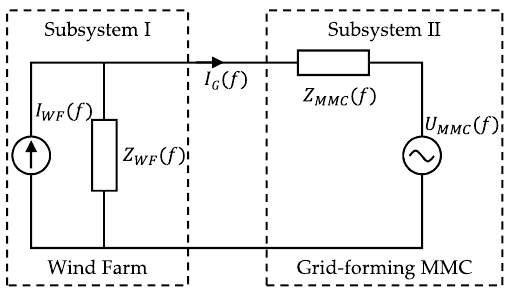
Figure 26. Equivalent circuit diagram of offshore test